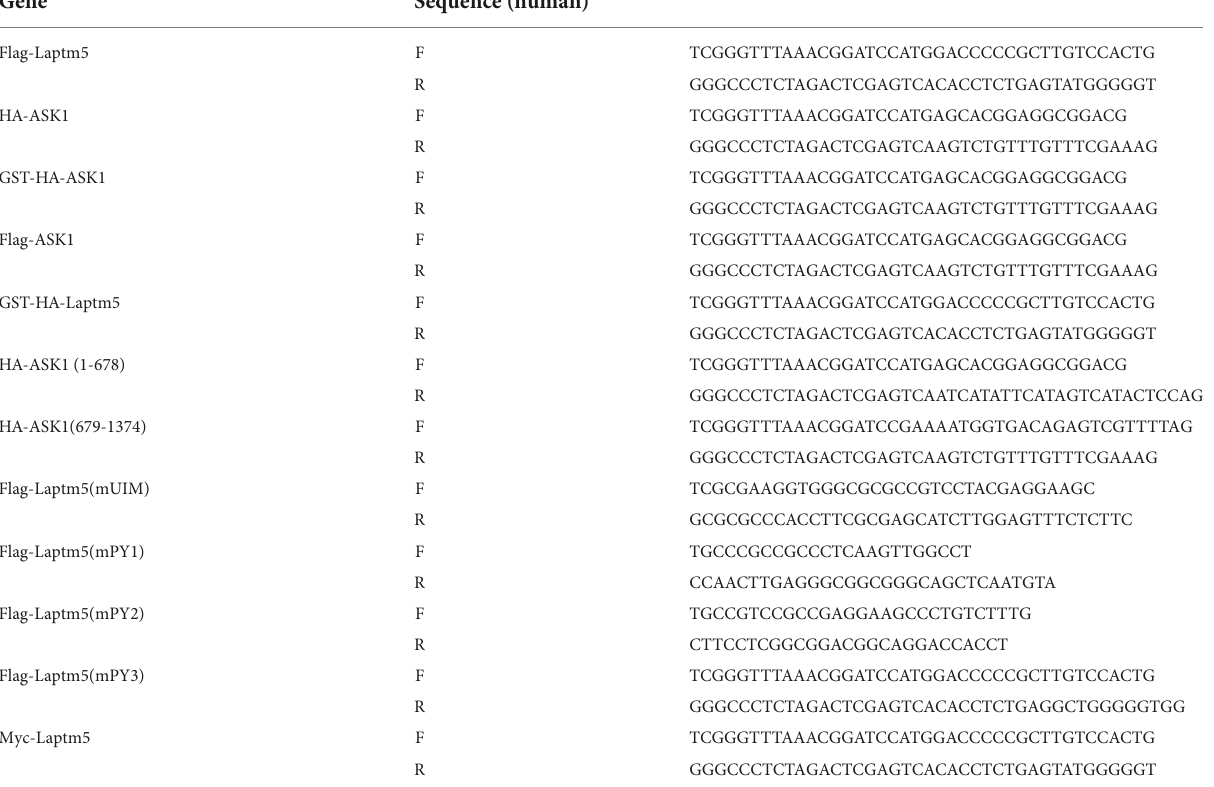
TABLE 5 Primer sequences for plasmid